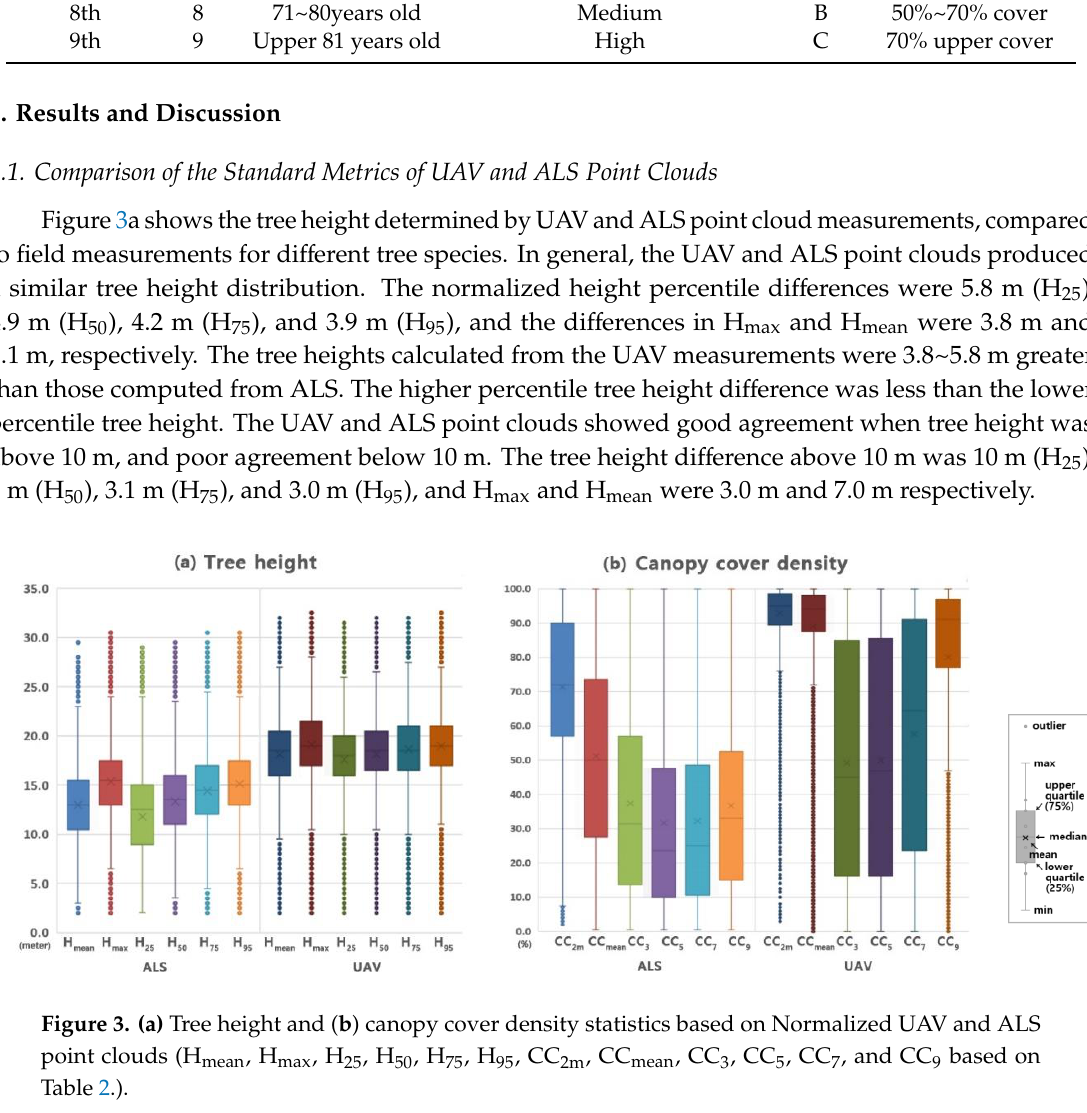
Table 4. Correlation between tree height data determined using UAV and ALS point clouds.